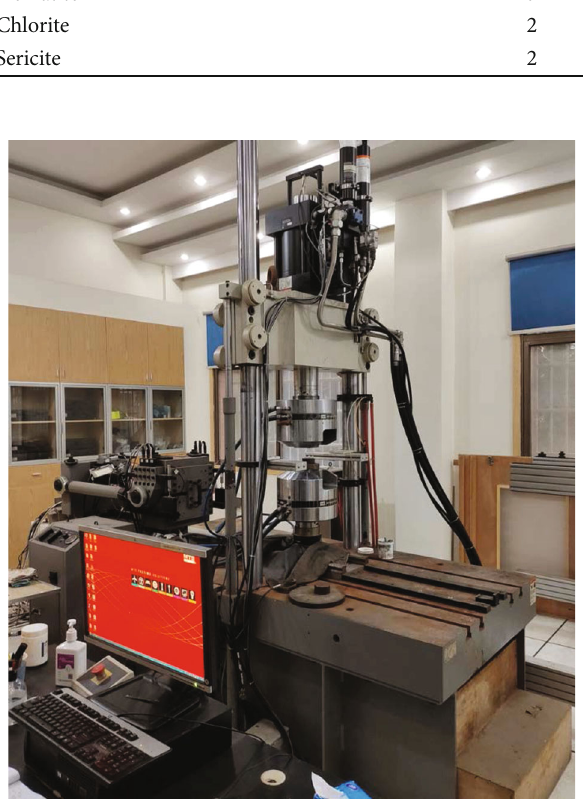
Figure 2: MTS-322 used for quasistatic